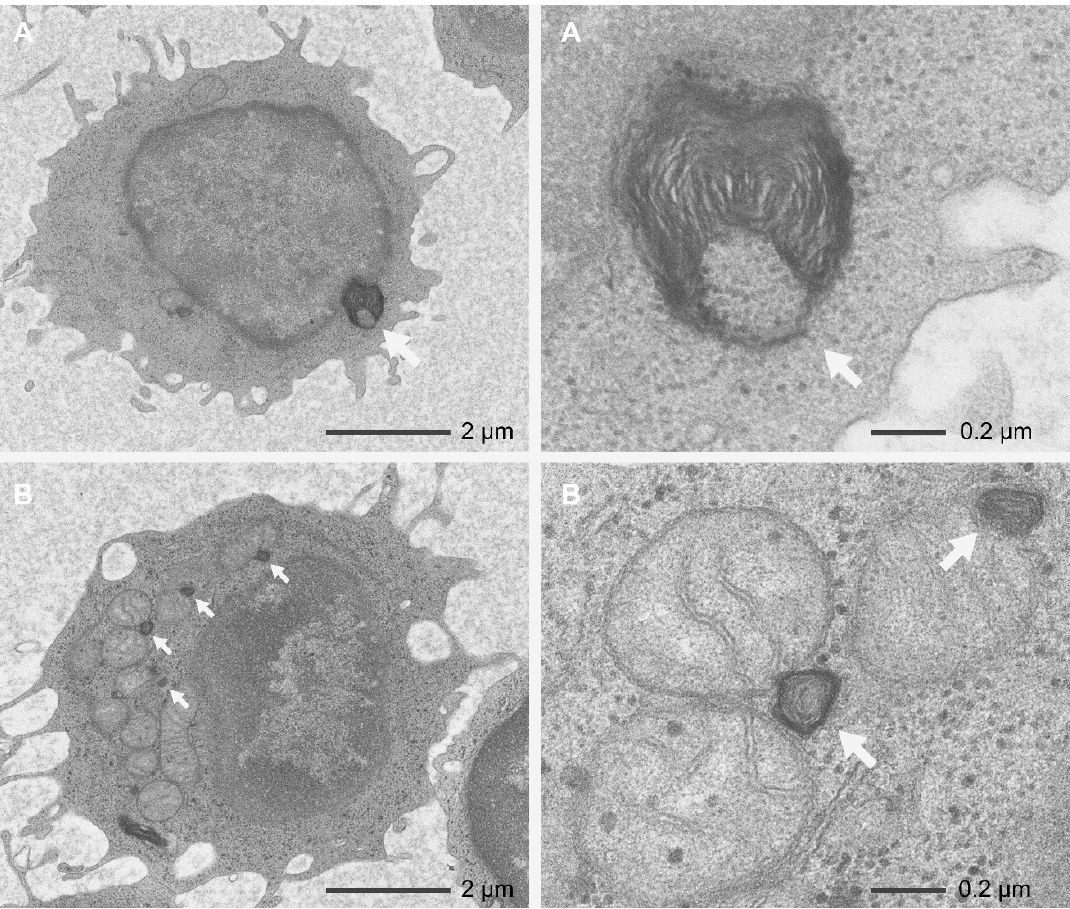
Figure 6. Transmission electron microscopic images of the peripheral lymphocytes in Patient 1 . The left column shows the entire images of lymphocytes, and the right column shows the magnified images focusing on myelin-like lamellar structures. The images show myelin-like lamellar structures (arrows) around the nucleus ( A ) and mitochondria ( B ).